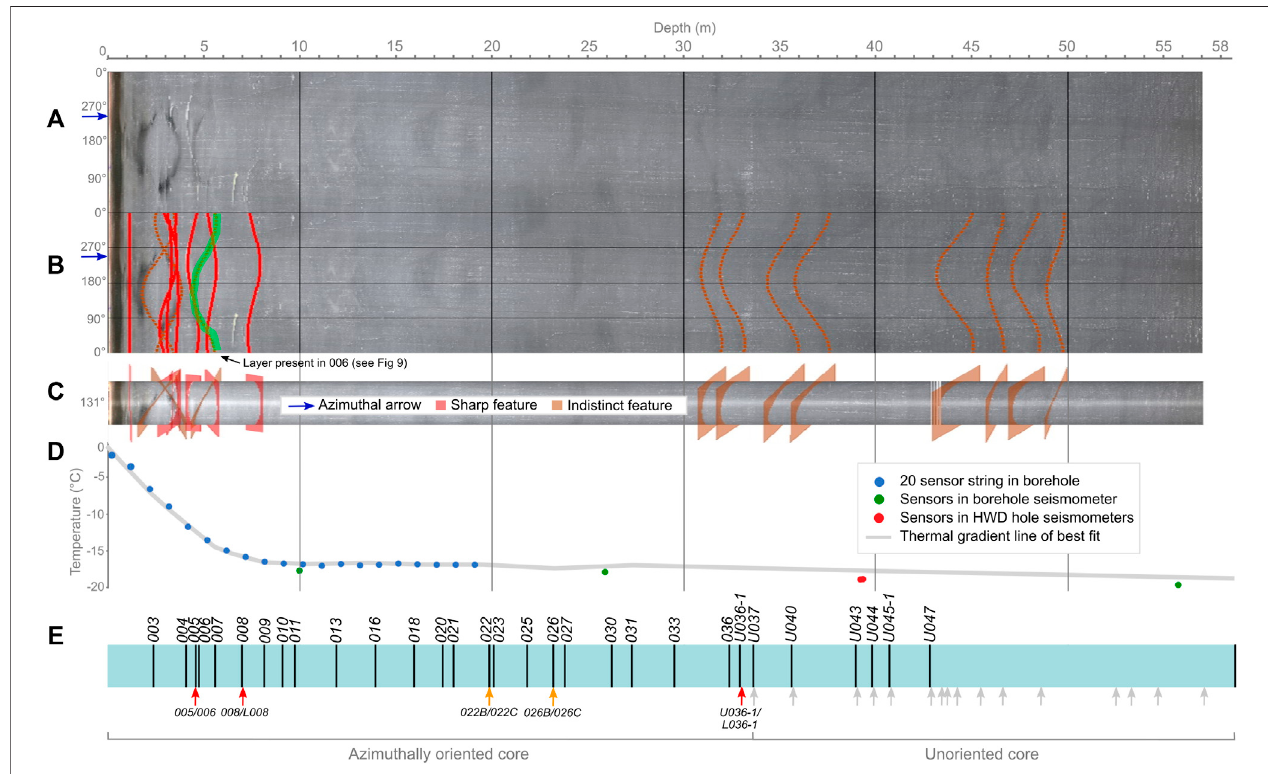
FIGURE 3 | Record of the Priestley Glacier ice core and borehole. (A) Borehole televiewer image of the borehole walls with (B) identi fi ed features shown as sinusoidal waves. Note that the angles of these features are vertically fl attened and not representative of actual dip angles. Blue azimuthal arrow denotes the location of the initial fi ducial mark drawn in the borehole at the beginning of core collection. (C) Visualization of layer and fracture planes down the borehole. Oriented to the fi ducial line. (D) In situ thermal pro fi le (grey line of best fi t) recorded from temperature sensors down the borehole and nearby hot water drilling (HWD) boreholes after core extraction. (E) Sample locations and names. Orientation breaks observed during core collection in the fi eld and fi xed using cryo-EBSD analysis are shown with a red arrow. Orientationbreaks fi xedonthepolarized lightstageareshownwithanorangearrow. Allunorientedbreaksareshownwithagreyarrow. Pairsofsamplesusedto restore orientation breaks down the core are given below their corresponding